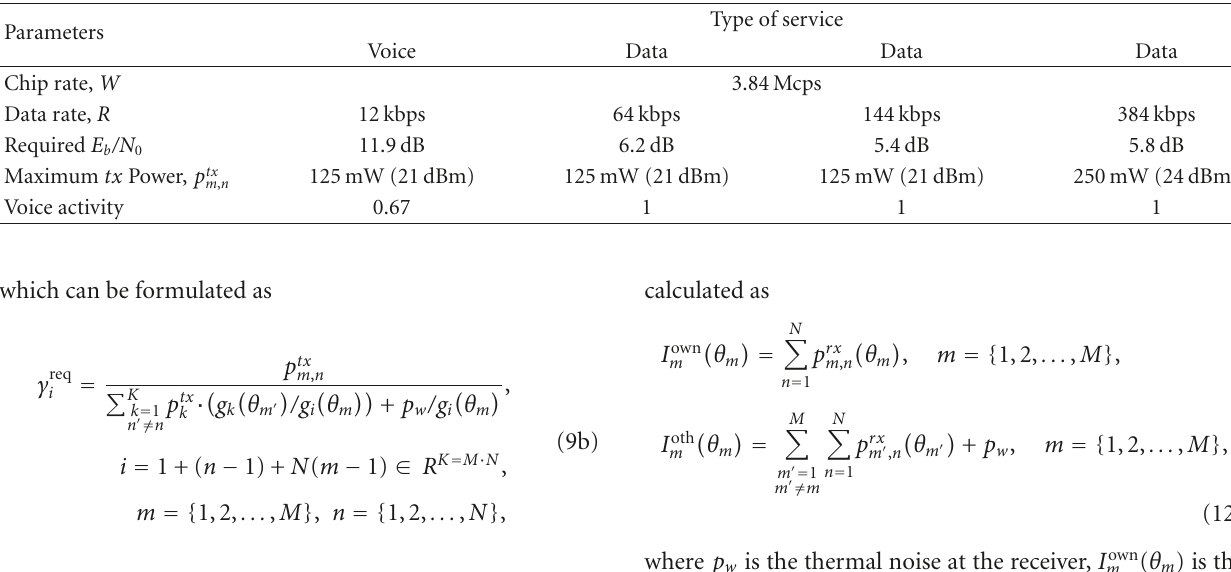
Table 2: WCDMA service parameters employed in the